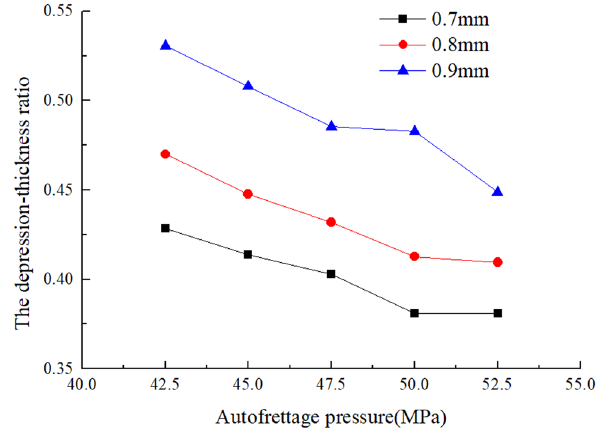
Figure 8: Relationship between the depression - thickness ratio and autofrettage pressure considering the variation of liner